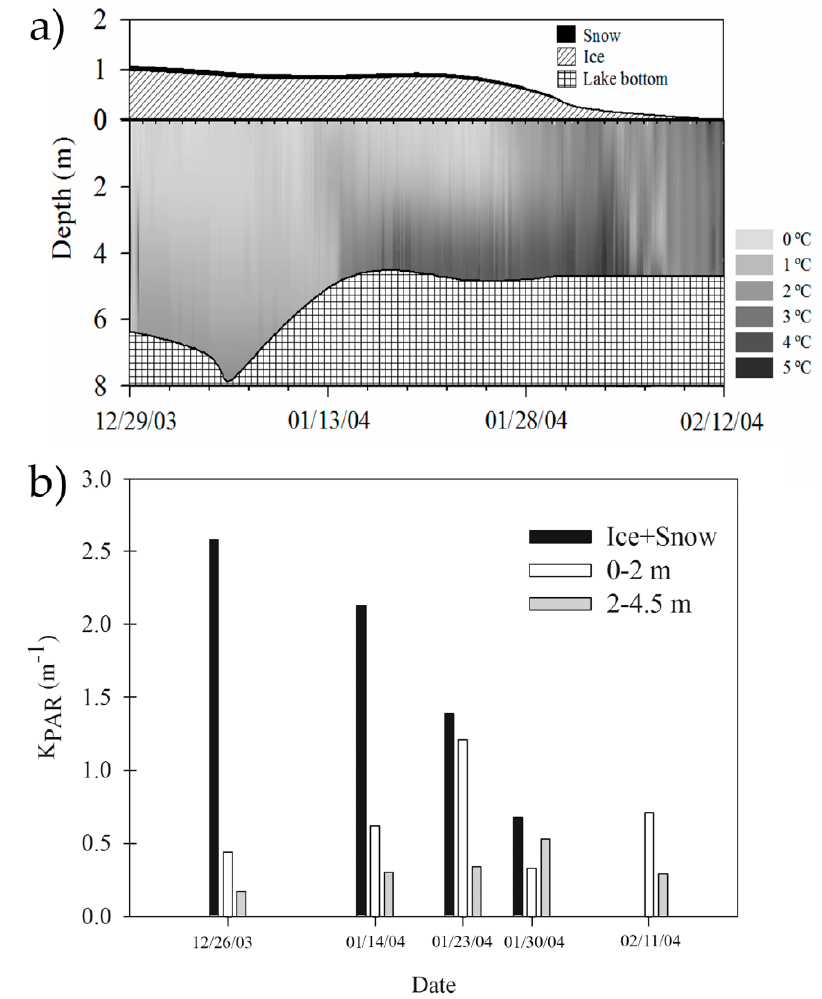
Figure 5. Major physical changes occurring in the water column of Lake Limnopolar during the 2003/04 summer transition from the ice-cover to ice-free period. ( a ) Time-course of snow/ice cover and the temperature regime in Lake Limnopolar obtained with a thermistors chain; ( b ) Changes in the extinction coefficient of the photosynthetic active radiation (K PAR ) in the snow/ice cap and in the water column. Dates as month/day/year. Redrawn from Rochera et al. [41].